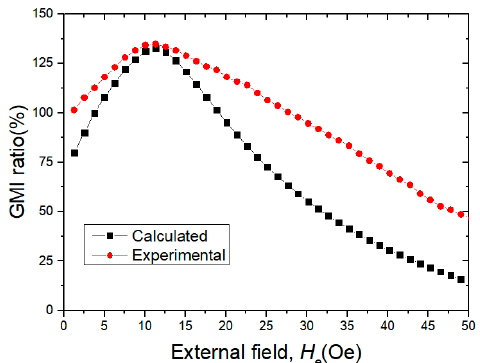
Figure 5. Experimental GMI values and calculated GMI data values.